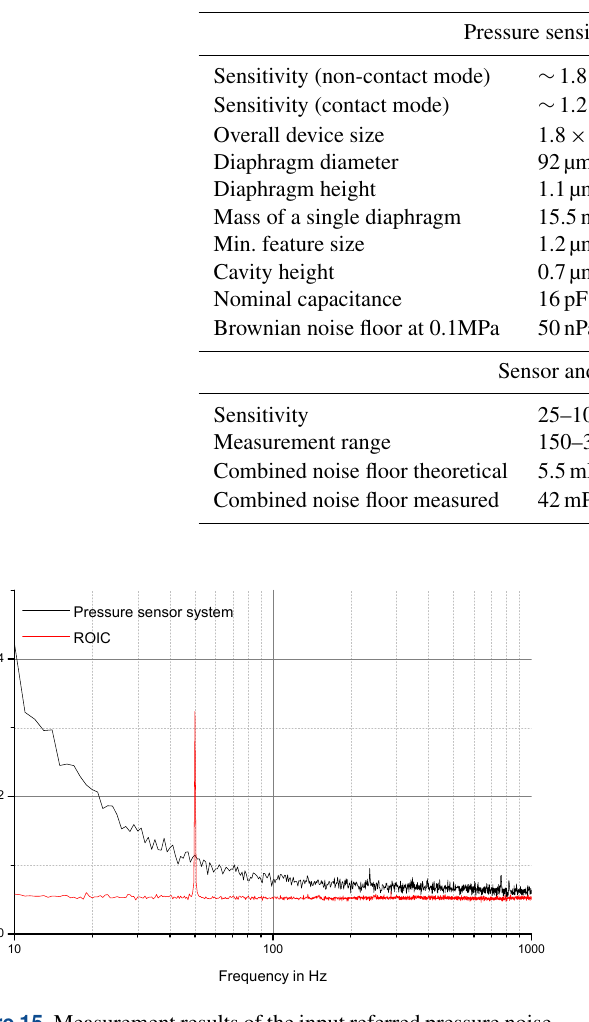
Figure 15. Measurement results of the input referred pressure noise at room temperature and atmospheric pressure, compared to the in- put referred noise of the ROIC